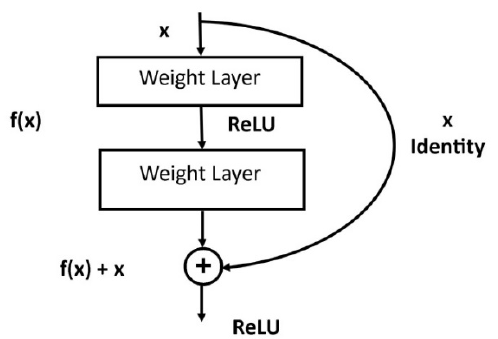
Figure 8. Building block of residual learning [80].